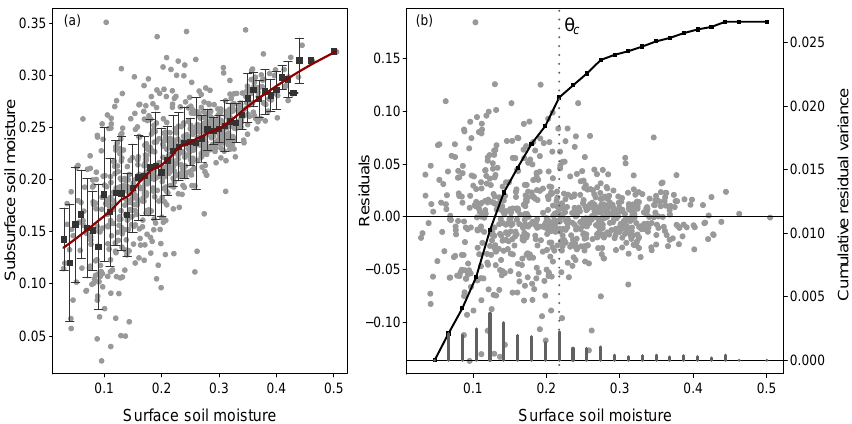
Figure 3. Schematic diagram using hypothetical soil moisture values to show vertical variability. (a) Scatter plot showing the trend with a fitted loess function. The variability can be seen using the standard deviation bars. (b) Scatter plot of the residuals from the fitted function. Soil moisture variability is visible from the variance given by the vertical bars and the cumulative residual variance given by the black line. A change in variability at an intermediate soil moisture value is marked by a change in the slope of the cumulative variance line, indicated by θ c